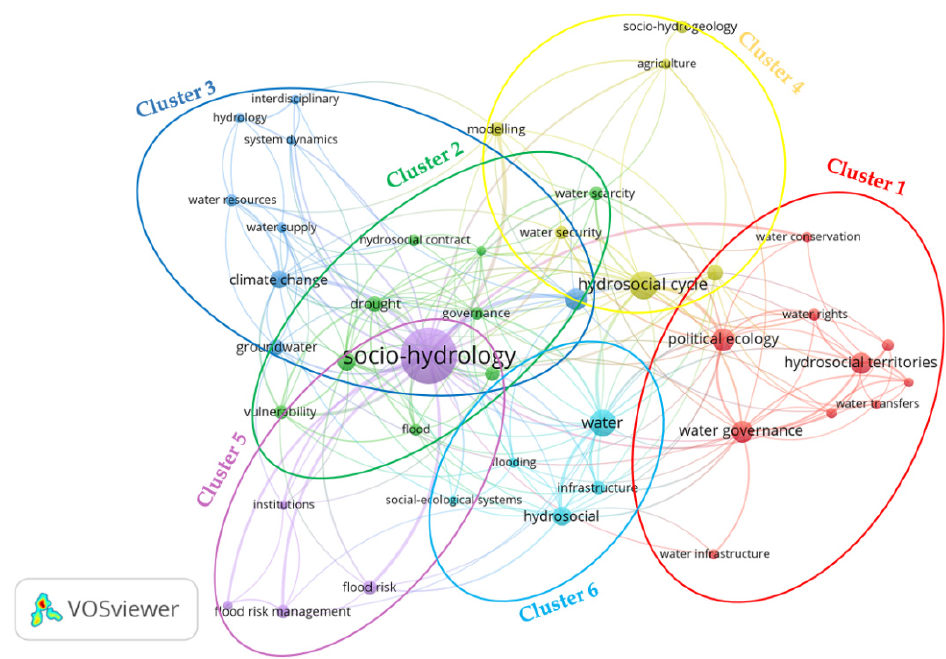
Figure 8. Co-Occurrence of Author Keyword Map.